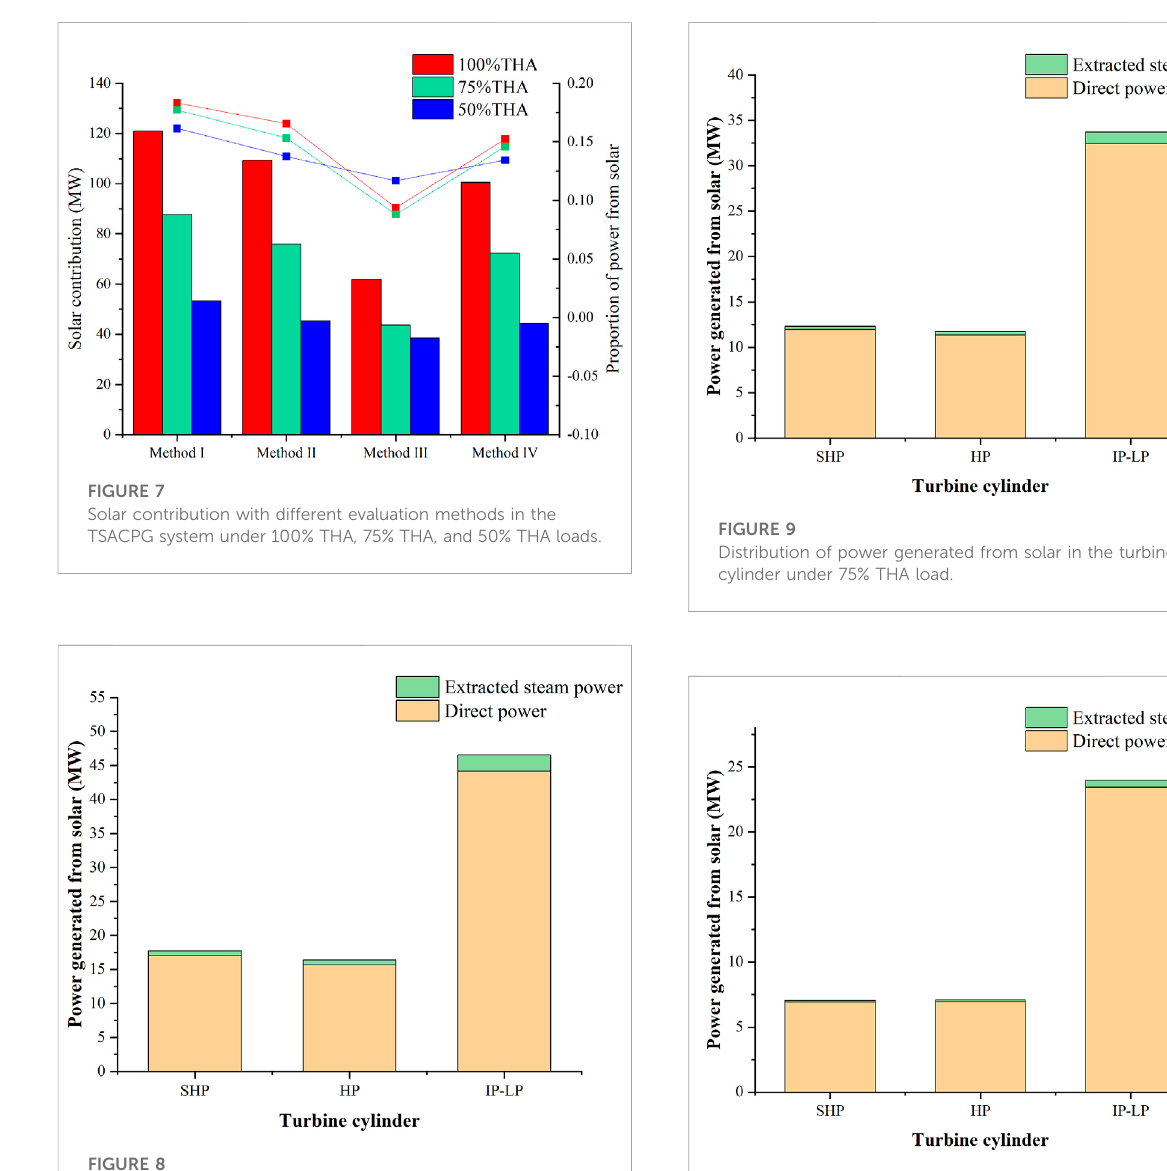
FIGURE 8 Distribution of power generated from solar in the turbine cylinder under 100% THA load.